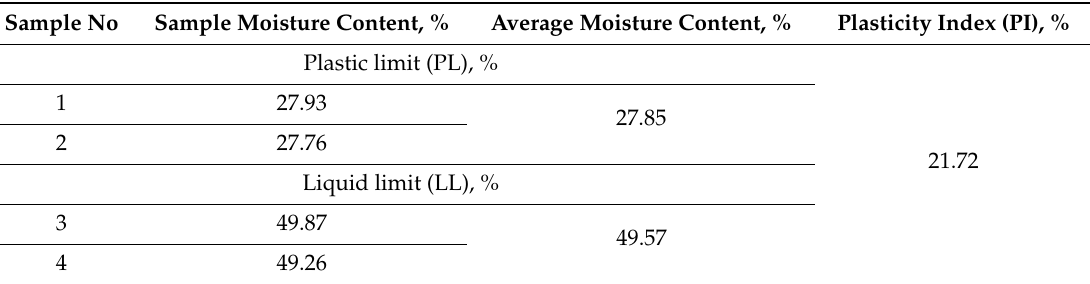
Table 1. The characterization of clay by Atterberg’s limits.